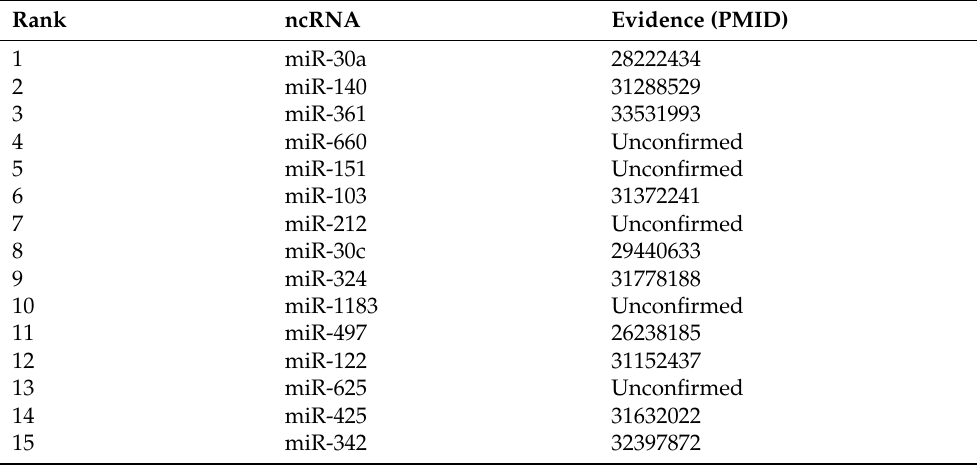
Table 5. The top 15 miRNAs related to Cisplatin resistance predicted by LRGCPND.